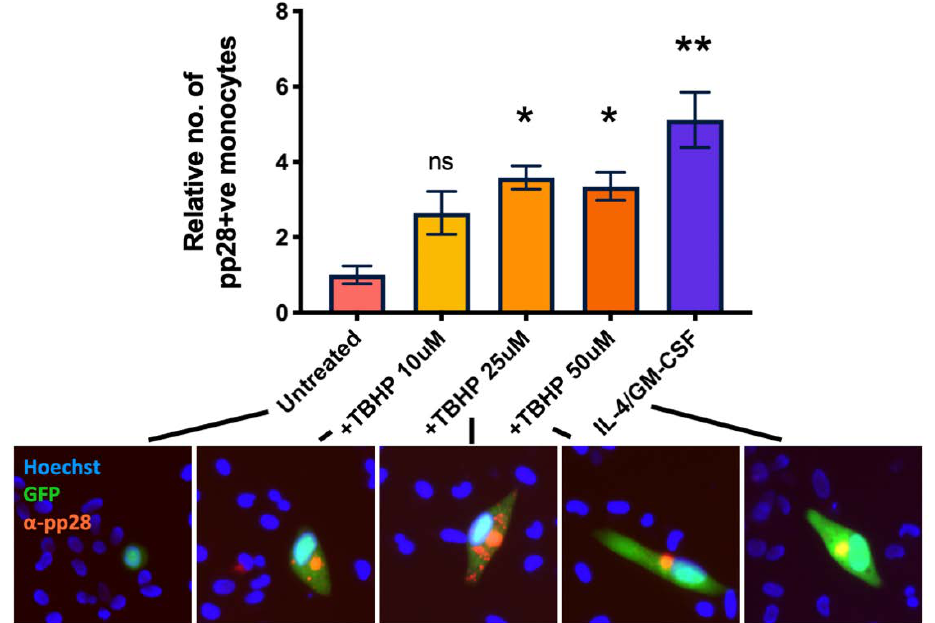
Figure 7. Tert-butyl hydroperoxide also prevents the establishment and maintenance of latency. CD14+ monocytes were infected with WT TB40E SV40-GFP virus at an MOI of 5. 2 d.p.i, cells were treated with increasing amounts of TBHP, or with IL-4/GM-CSF + LPS as a positive control for reactivation. 7 d.p.i, cells were fixed and stained for the late lytic protein, pp28. pp28-positive monocytes were enumerated for each condition. Error bars represent the standard deviation from experiments performed in triplicate. Significant difference from untreated cells was determined by a one-wat ANOVA with Dunnett’s post hoc testing. ns = not significant, * = p < 0.05, ** = p < 0.01. Merged colour channel images for each condition were produced on ImageJ (20 × ). Exposure of green channel was reduced in some images for